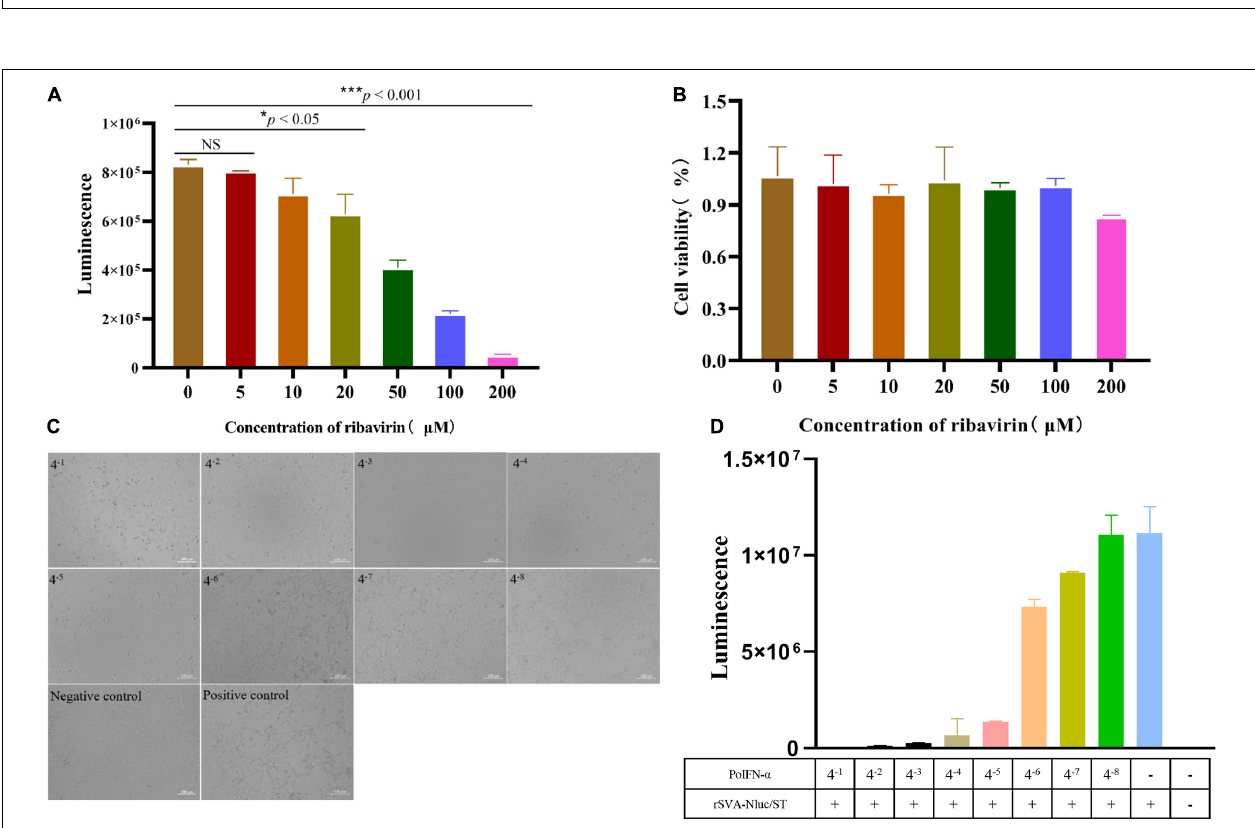
FIGURE 7 | Screening of antiviral drug and PoIFN- α protein using rSVA-Nluc. (A) Effects of ribavirin on rSVA-Nluc replication. BHK-21 cell monolayers were pretreated with various concentrations of ribavirin followed by infection with rSVA-Nluc at an MOI of 0.1 in 48-well plates, and the Nluc activity was measured at 48-h post-infection. (B) MTT [3-(4,5-dimethylthiazol-2-yl)-2,5-diphenyltetrazolium bromide] method is used to detect BHK-21 cell cytotoxicity. The statistical significance of differences was determined using Student’s t -test (NS, not significant; *p < 0.05; **p < 0.01; ***p < 0.001). (C) The effect of different concentrations of PoIFN- α on SVA-infected cell pathology. ST cell monolayers were pretreated with various concentrations of PoIFN- α followed by infection with rSVA-Nluc at an MOI of 0.1 in 96-well plates, the cytopathic effect was observed under a microscope. (D) Luciferase activity to detect the effect of PoIFN- α on virus replication.